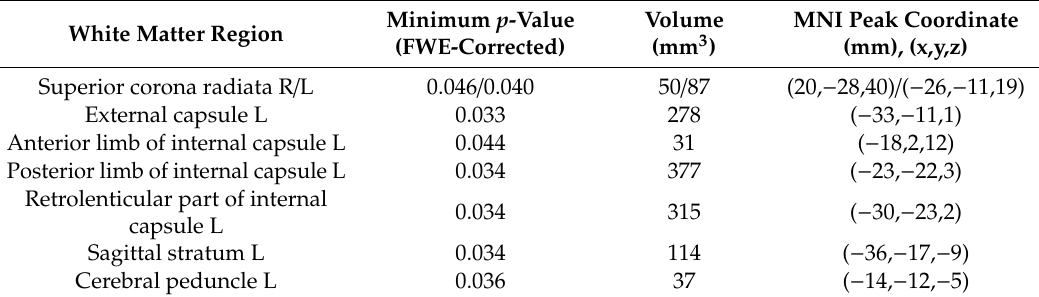
Table A4. White matter regions from the ICBM-DTI-81 White Matter Atlas for which significant decreased RTPP values were found in EM compared to HC including the duration of the migraine as a covariate.